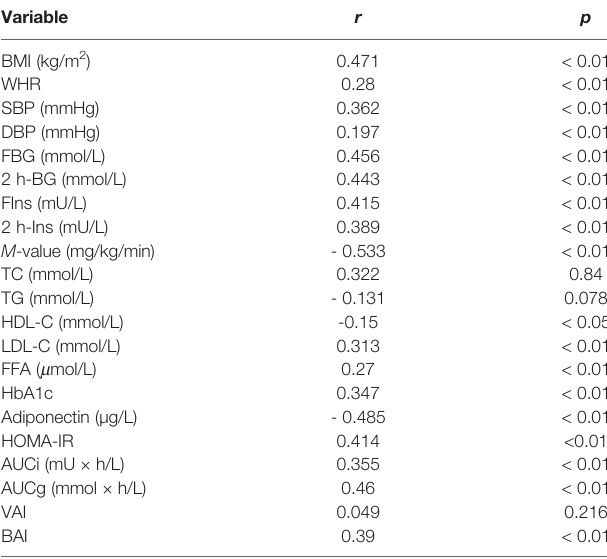
TABLE 2 | Spearman correlation analysis of circulating GPHB5 and other indexes in all study population. Variable r p BMI (kg/m 2